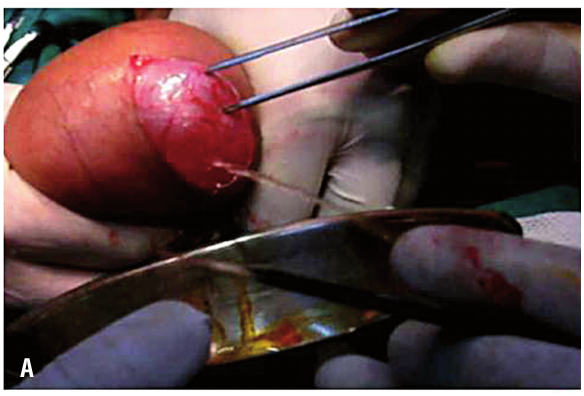
Figure 2B - An operative photograph showing in situ excision of the hydrocele sac using electrocautery.